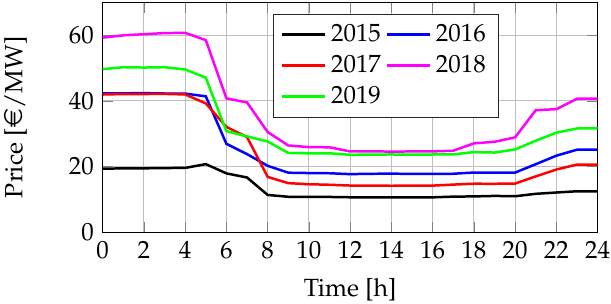
Figure 8. Average hourly prices of FR in DK2 [24,26].